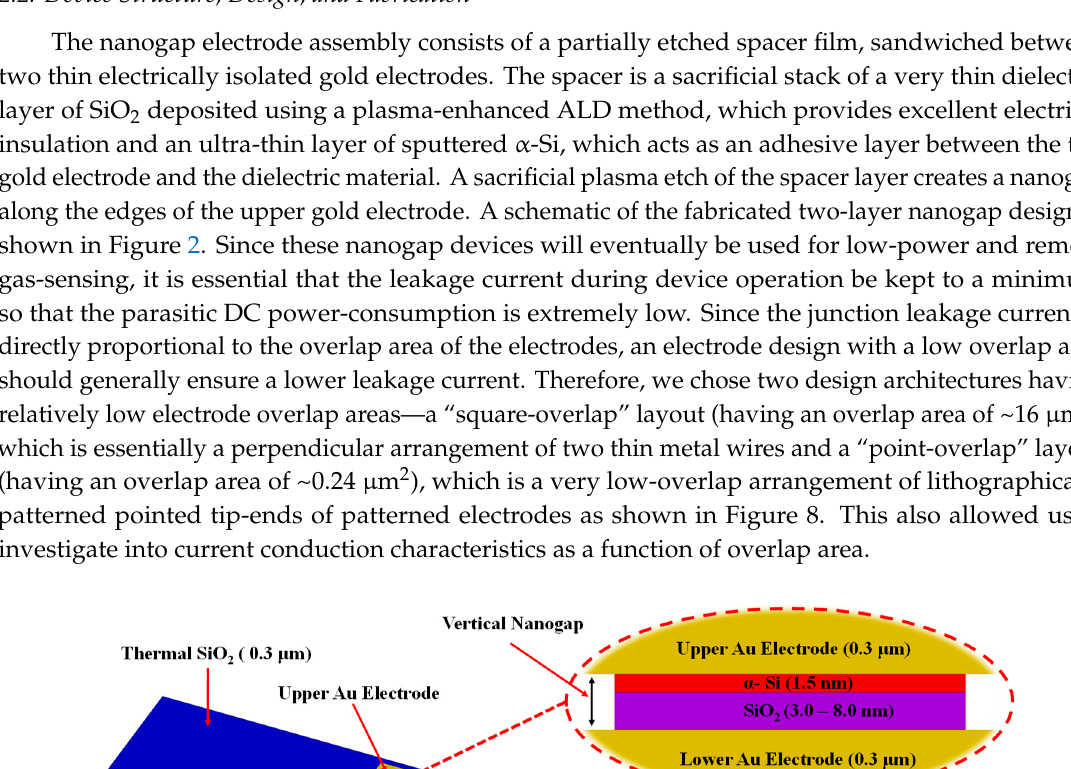
Figure 3. Simplified fabrication process of vertical nanogap electrodes separated by a thin spacer layer. (a) 4” Si wafer, (b) Thermally grown 300 nm SiO 2 , (c) Deposit 200 nm Au bottom electrode and (d) pattern lithographically, (e) Deposit spacer layer, (f) Deposit 200 nm top Au electrode and (g) pattern, (h) SF 6 dry etch to form nanogap. 2.2. Choice of Spacer Stack: SiO 2 As the Dielectric Material and Using α‐ Si As An Adhesive Layer Since the intended application of the fabricated nanogap sensors is chemical detection and resistance switching at very low standby DC power, the primary requirements of the chosen dielectric material are extremely low leakage current, very high off ‐ resistance, and compatibility with standard CMOS fabrication techniques. Keeping these factors in mind, plasma ‐ enhanced ALD SiO 2 was chosen as a dielectric material since for a given geometry and thickness of dielectric film, and operating bias voltage, the leakage current is lowest for SiO 2 films [23]. Since Au is a noble metal, it is chemically inert and does not easily form oxides. Therefore, Au does not adhere well to dielectric films like SiO 2 , which is widely used in CMOS processes. Although the sputtering of Au at elevated temperatures on SiO 2 substrates is an effective solution [24], the most common practice is to deposit a thin metallic adhesive layer of Cr, Ti, or Ni before depositing the layer of Au. However, such adhesive layers have been known to cause thermal degradation of the film because of grain ‐ boundary diffusion [24], and to ensure a very high off ‐ resistance of the device, using a non ‐ metallic adhesive layer could be a possible solution. Taking this into consideration, we report a novel application of an ultra ‐ thin layer of sputtered α‐ Si as an effective adhesive layer for Au in microfabrication processes. 2.3. Imaging and Electrical Characterization of Nanogap Electrodes After fabrication of the devices, high ‐ resolution SEM imaging was done at an accelerating voltage of 15.0 kV by the FEI Nova NanoSEM to inspect the gap formed between the Au electrodes. The I–V characteristics of the nanogap devices were measured on the Keithley 4200A ‐ SCS Semiconductor Parameter Analyzer to ensure that the electrodes were electrically isolated after the nanogap formation and that the resistance between them was substantially high before chemical functionalization and exposure to target analyte. To ensure low ‐ noise and high ‐ fidelity electrical